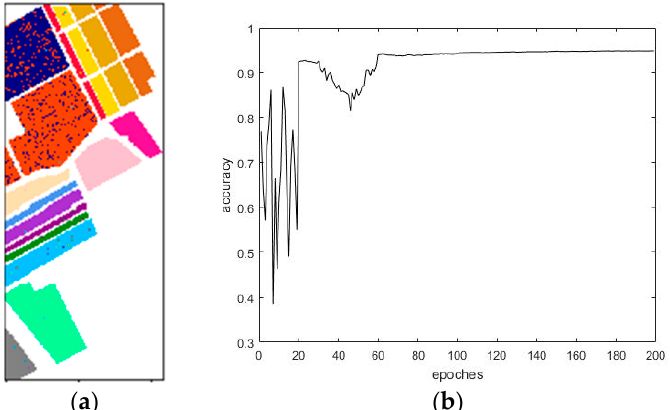
Figure 12. ( a ) Traditional CNN classification results. ( b ) Traditional CNN classification accuracy results.